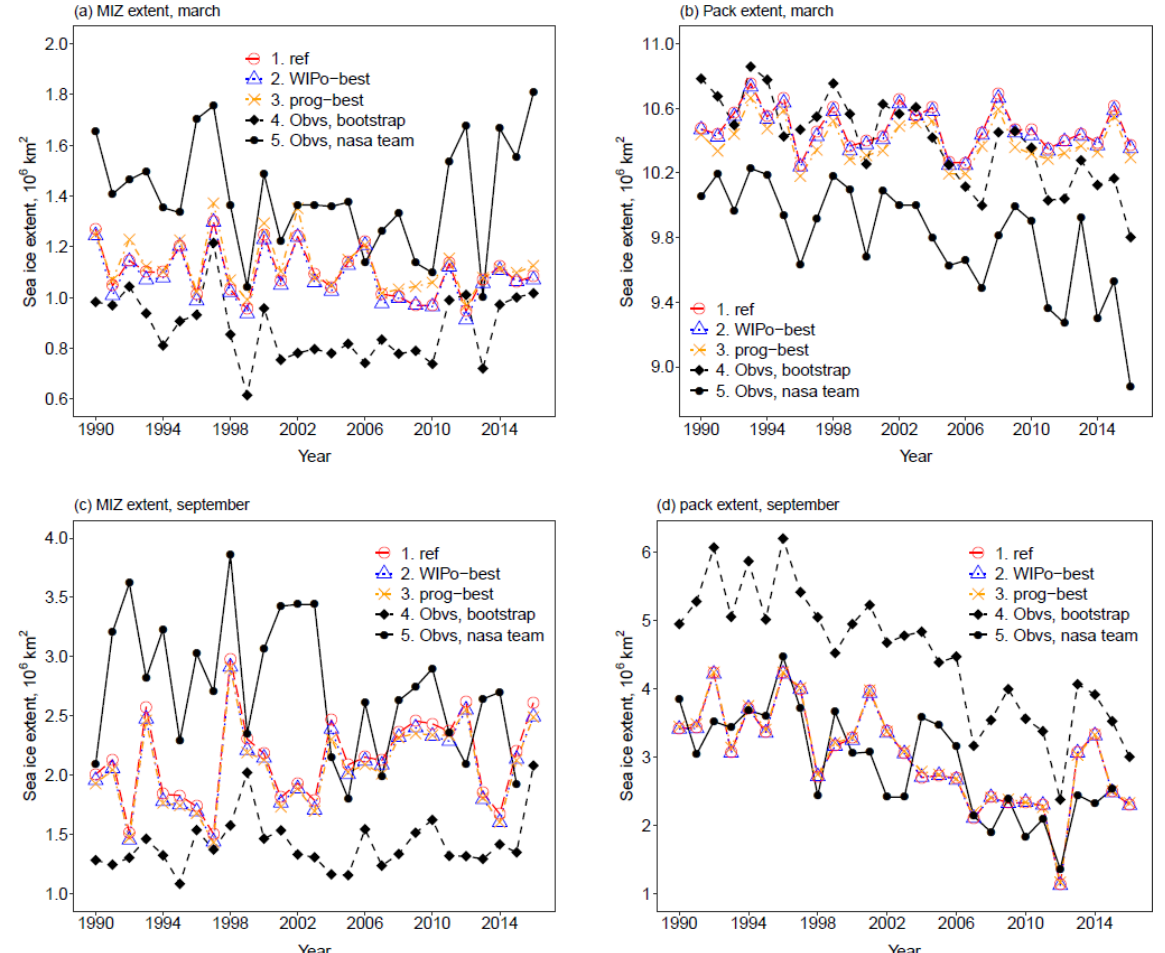
Figure 6. The total March MIZ extent (a) , March pack extent (b) , September MIZ extent (c) , and September pack extent (d) for Arctic sea ice over the period 1990–2016 for ref (red, circles, long dashed), WIPo-best (blue, triangles, dotted), prog-best (yellow, cross, dotted–dashed), and observations (black). Sea ice concentration data are obtained from satellites using the Bootstrap (filled diamond, dashed) algorithm version 3 (Comiso, 1999) and the NASA Team (filled circle, solid) algorithm version 1 (Cavalieri et al., 1996). Sea ice volume data (filled diamond, dashed) are taken from PIOMAS (Zhang and Rothrock, 2003). The MIZ is here defined as the region with between 15% and 80% sea ice